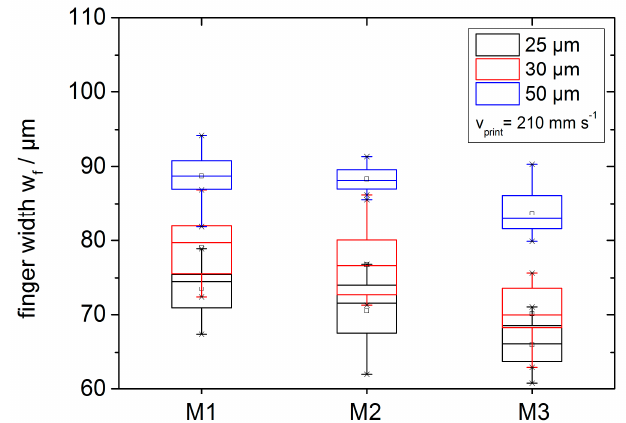
Figure 9. Finger width values for M1, M2, and M3 printed through 25, 30, and 50 µm finger openings at v print = 210 mm s − 1 .